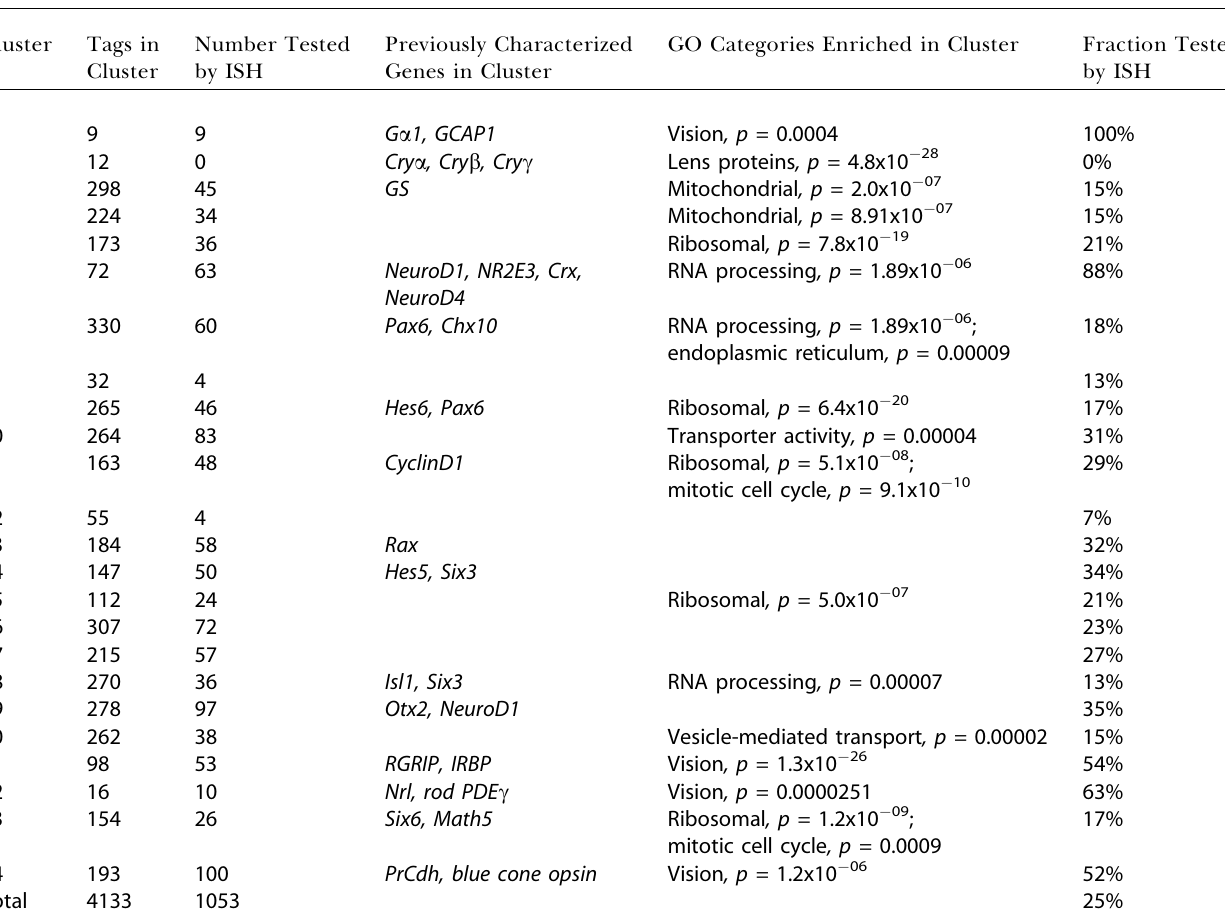
Table 1. Summary of SAGE Tag K- Means Cluster Data Cluster Tags